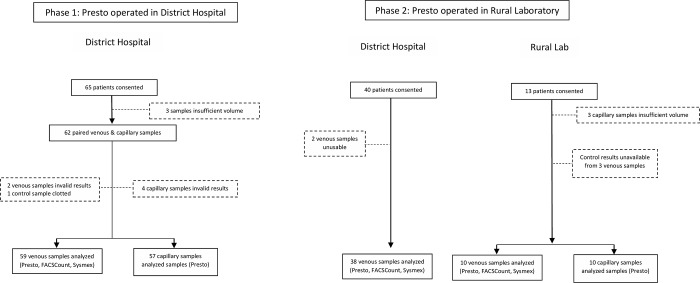
Study recruitment for phase 1 and 2.Participants were recruited sequentially from both the district hospital (DH) and the rural laboratory. In phase 1, all samples were analyzed in the DH from DH patients, and in phase 2, samples came from both DH and rural laboratory patients and all were analyzed in the rural laboratory.